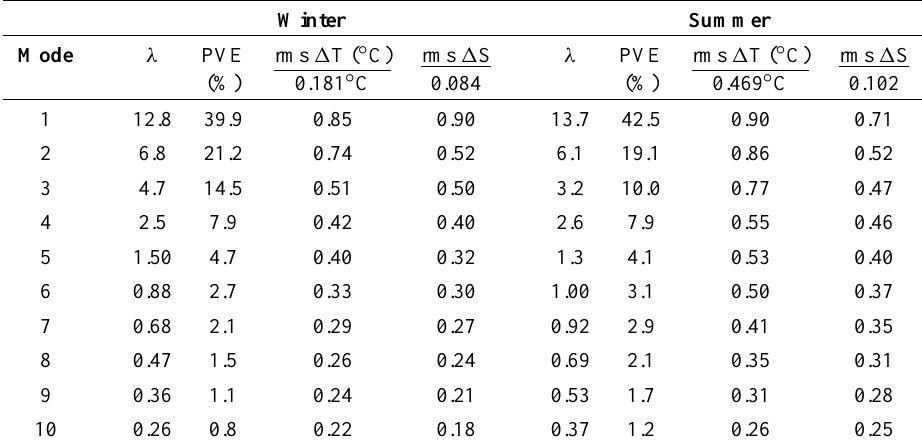
Table 4. The first ten eigenvalues of the covariance matrix of the insitu data in region 3 for winter and summer. The first column contains the eigenvalues. The percentage of the variance explained (PVE, Eq. (3) is shown in the second column. In the remaining two columns for each season, the ratio of the vertical average of the root mean square residual (7b) to the vertically averaged standard deviation (7a) is also shown. This latter is shown only for the layer between 0 and